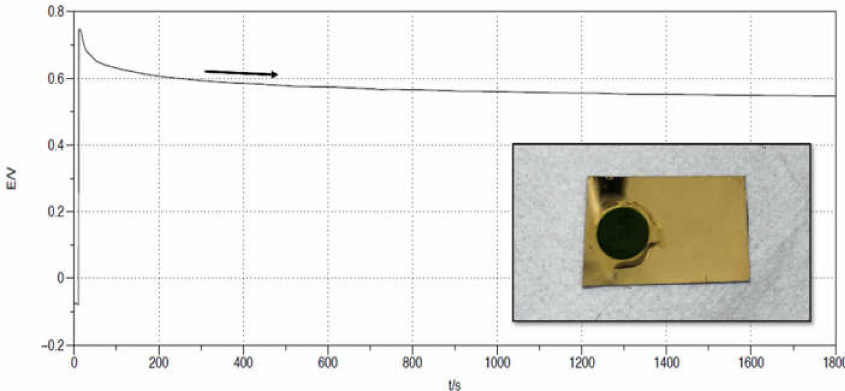
Figure 2. PANI galvanostatic electropolymerization on a Au/Si WE, in a 3-electrodes cell. Pt was used as CE, Ag/AgCl/KCl sat as Ref. The electrolyte consists of aniline (0.1 M) in a H 2 SO 4 (1 M) aqueous solution. A total of 0.25 mA of current was imposed for 1800 s. The inset displays the produced